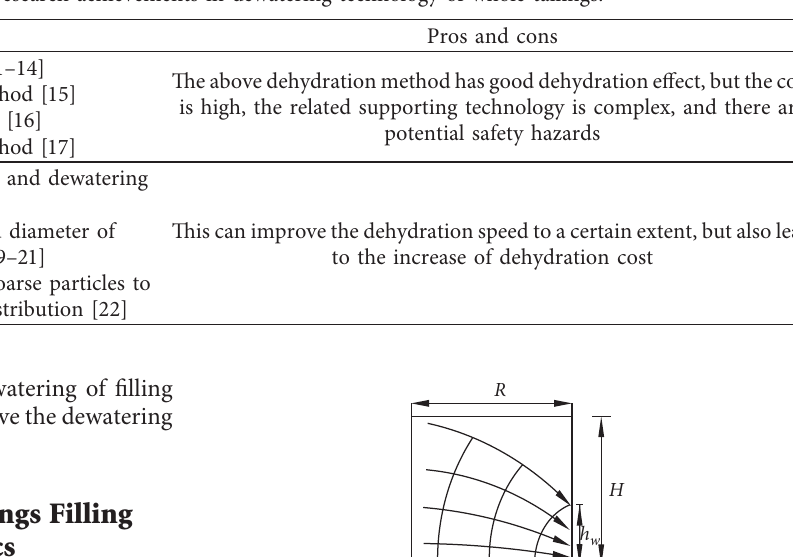
Table 1: Summary of research achievements in dewatering technology of whole tailings.